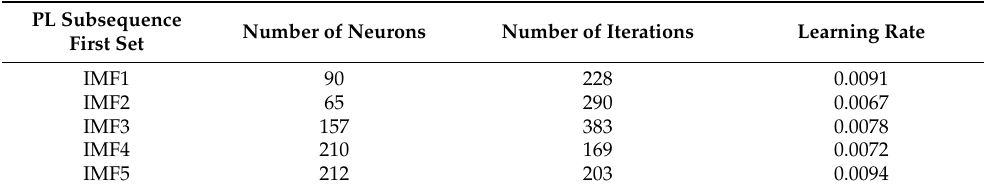
Table 7. Results of hyperparameters optimized by PSO based on first set PL.